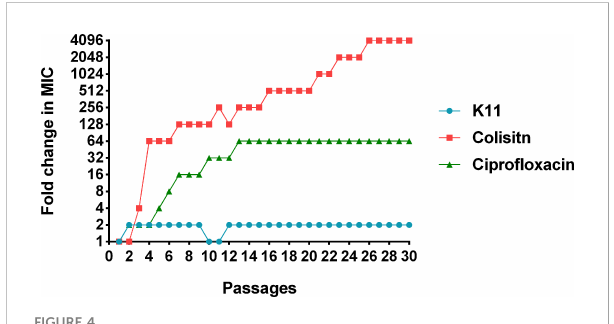
FIGURE 4 The change of MICs of K11 against K. pneumoniae ATCC BAA-1706 strain after 30 consecutive days of treatment. Cipro fl oxacin and colistin were used as